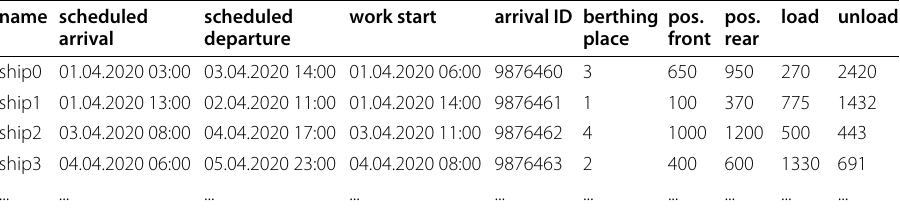
Table 2 Anonymized example sailing list entry name scheduled